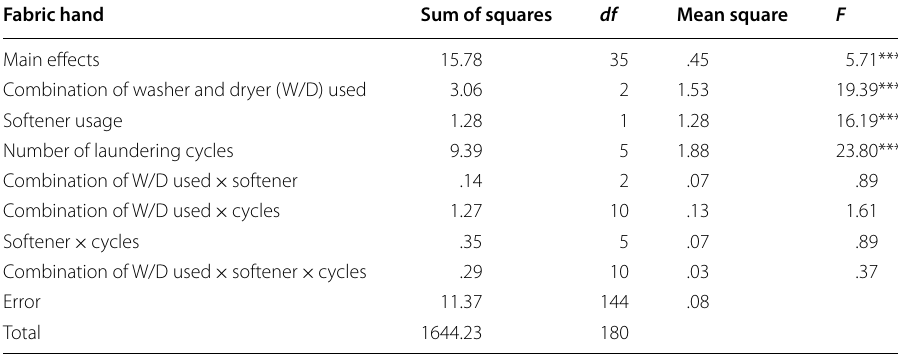
*** p < .001 Table 2 Mean differences in fabric hand and fabric smoothness by three combinations of washer and dryer used